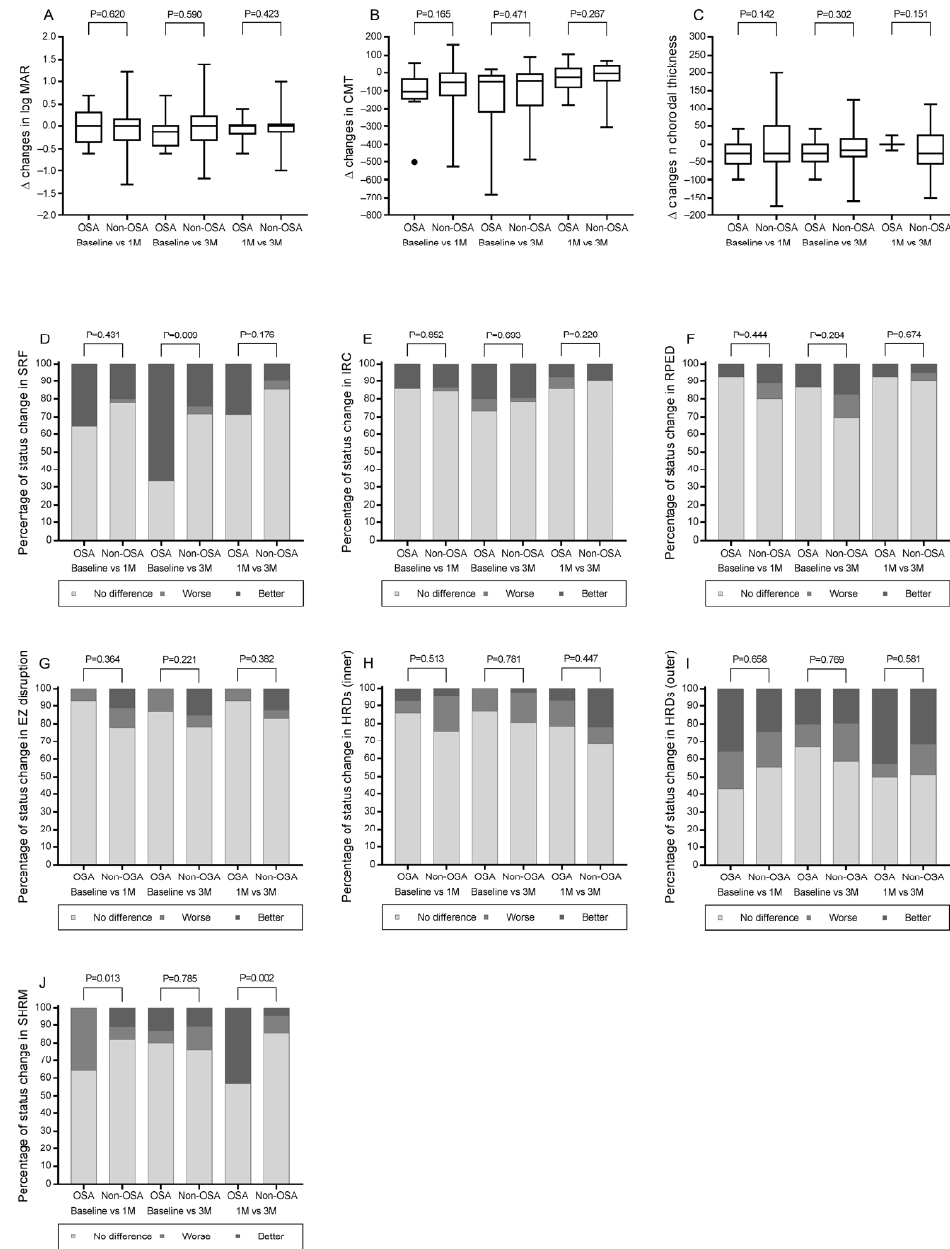
Figure 1. Changes in functional and anatomical outcomes after anti-VEGF treatment. The box plots show differences (medians) between the OSA and non-OSA groups in changes in ( A ) log MAR, ( B ) CMT, and ( C ) choroidal thickness determined from Mann–Whitney U tests. The bar graphs show differences (percentages) between the OSA and non-OSA groups in their changes in ( D ) SRF, ( E ) IRC, ( F ) RPED, ( G ) EZ disruption, ( H ) HRDs (inner), ( I ) HRDs (outer), and ( J ) SHRM from baseline to 1 and 3 months and from 1 to 3 months as determined from χ 2 tests. The dot was represented as outlier in subfigure ( B ). Abbreviations: CMT, central macular thickness; EZ, ellipsoid zone; HRDs, hyperreflective dots; IRC, intraretinal cysts; MAR, the minimum angle of resolution; RPED, retinal pigment epithelium detachment; SHRM, subretinal hyperreflective material; and SRF, subretinal